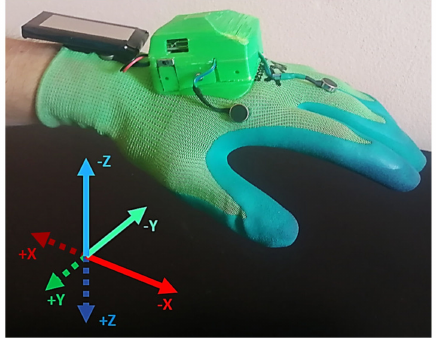
Figure 12. Hand position above the table during the experiment. The participants were instructed to identify the direction communicated by the device by moving the hand in the opposite direction (repulsive prompt) according to tactors’ placement. The movement directions corresponding to the activation of each tactor (+X, − X, +Y, etc.) are visualised as a coordinate